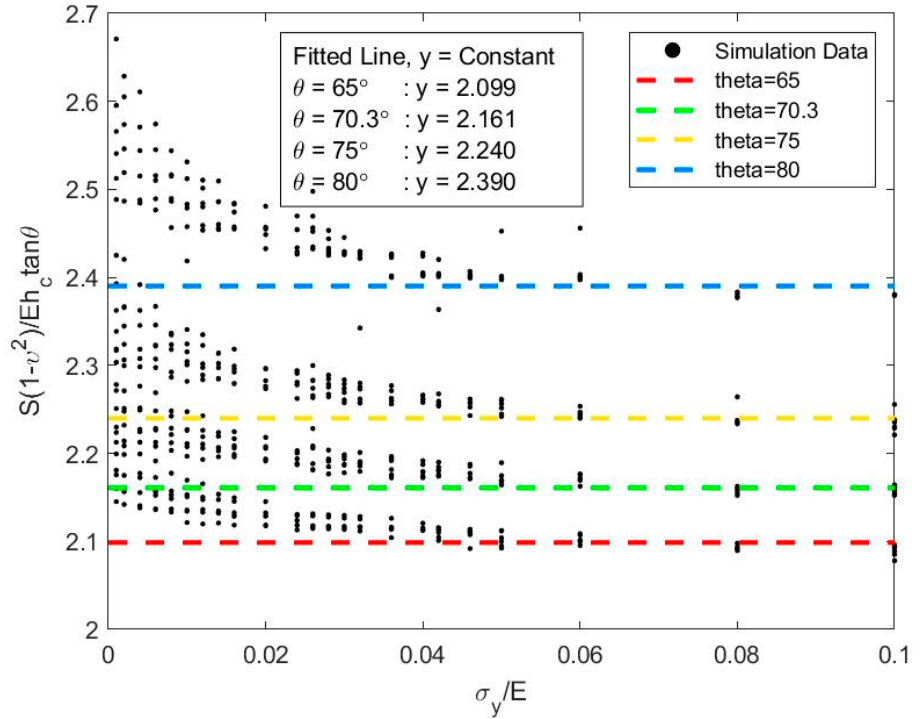
(cid:104)(cid:16) (cid:17) (cid:105) (cid:4670)(cid:4666)1 (cid:3398) 𝜈 (cid:2870) (cid:4667) 𝐸ℎ (cid:3030) 𝑡𝑎𝑛𝜃⁄ (cid:4671) 1 − ν 2 / Eh c tan θ (cid:3288) m